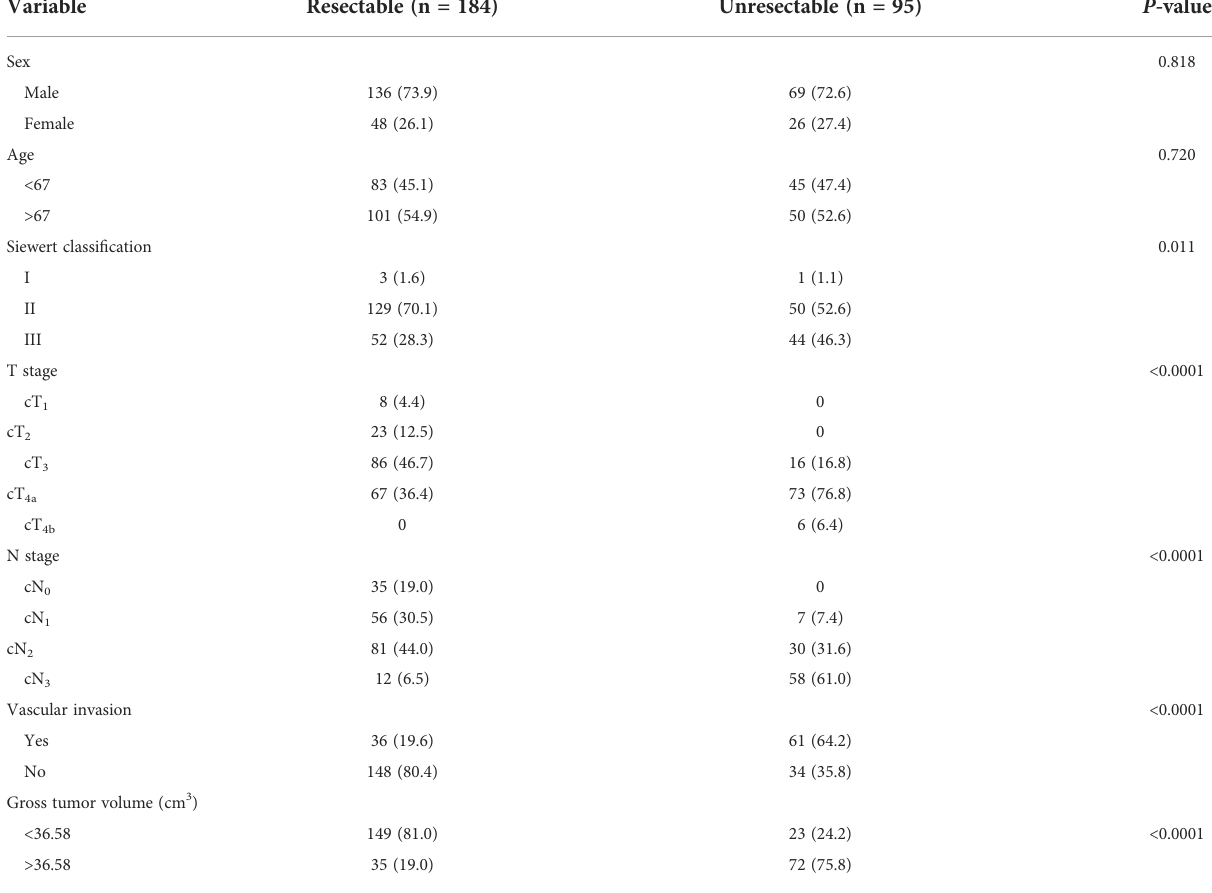
TABLE 3 Univariate analysis of clinical factors and gross tumor volume correlated with resectability in the training cohort.